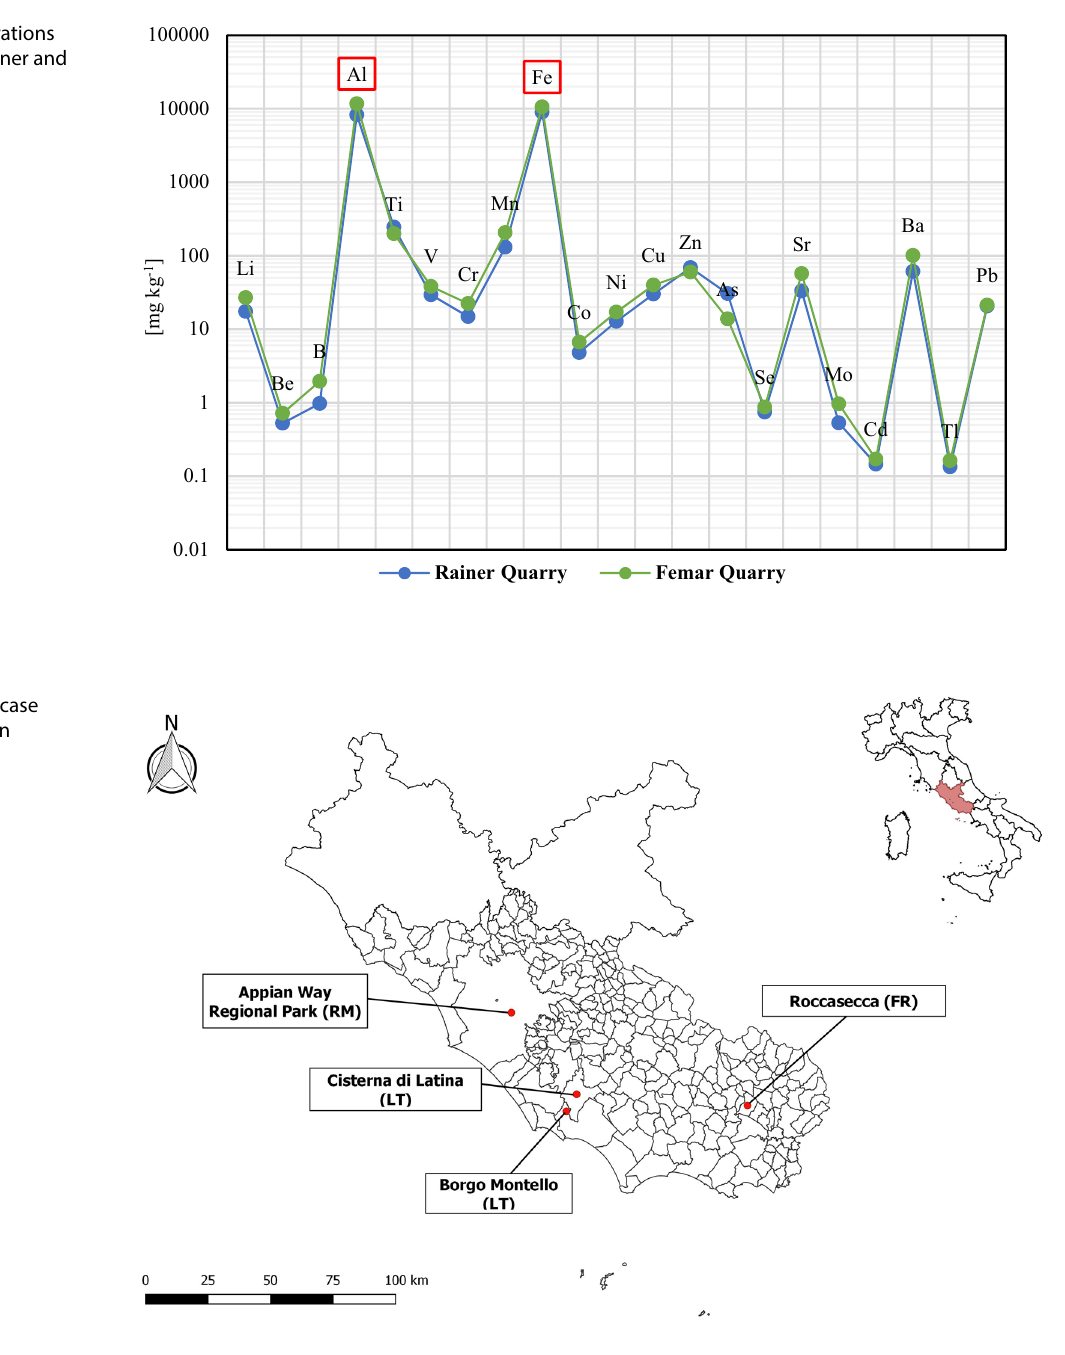
Fig. 3 Trend concentrations trace elements for Rainer and Femar Quarry